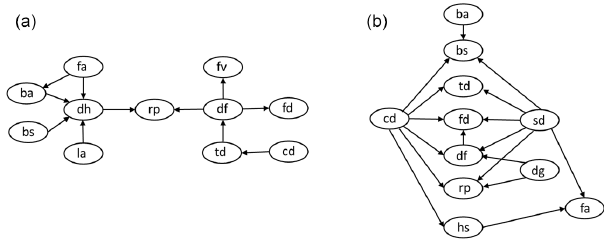
Figure 4. Bayesian network learned from data (a) and Bayesian network constructed by experts (b) . Note that not all variables are used in the